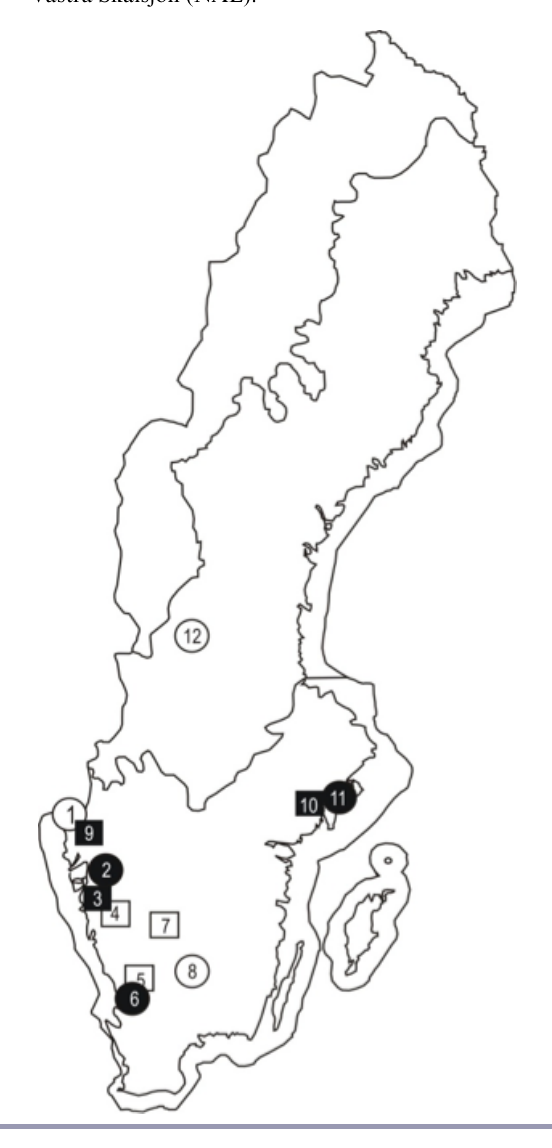
Fig. 1 . Localization of study lakes. Lake categories: acidified lakes (A; black squares), circumneutral lakes (N; black circles), naturally acidic, limed lakes (NAL; white circles), anthropogenically acidifed, limed lakes (AAL; white squares), 1 = Ejgdesjön (NAL), 2 = Fräcksjön (N), 3 = Härsvatten (A), 4 = Stora Härsjön (AAL), 5 = Gyltigesjön (AAL), 6 = Stora Skärsjön (N), 7 = Stengårdshultasjön (AAL), 8 = Gyslättasjön (NAL), 9 = Rotehogstjärnen (A), 10 = Brunnsjön (A), 11 = Allgjuttern (N), 12 = Västra Skälsjön